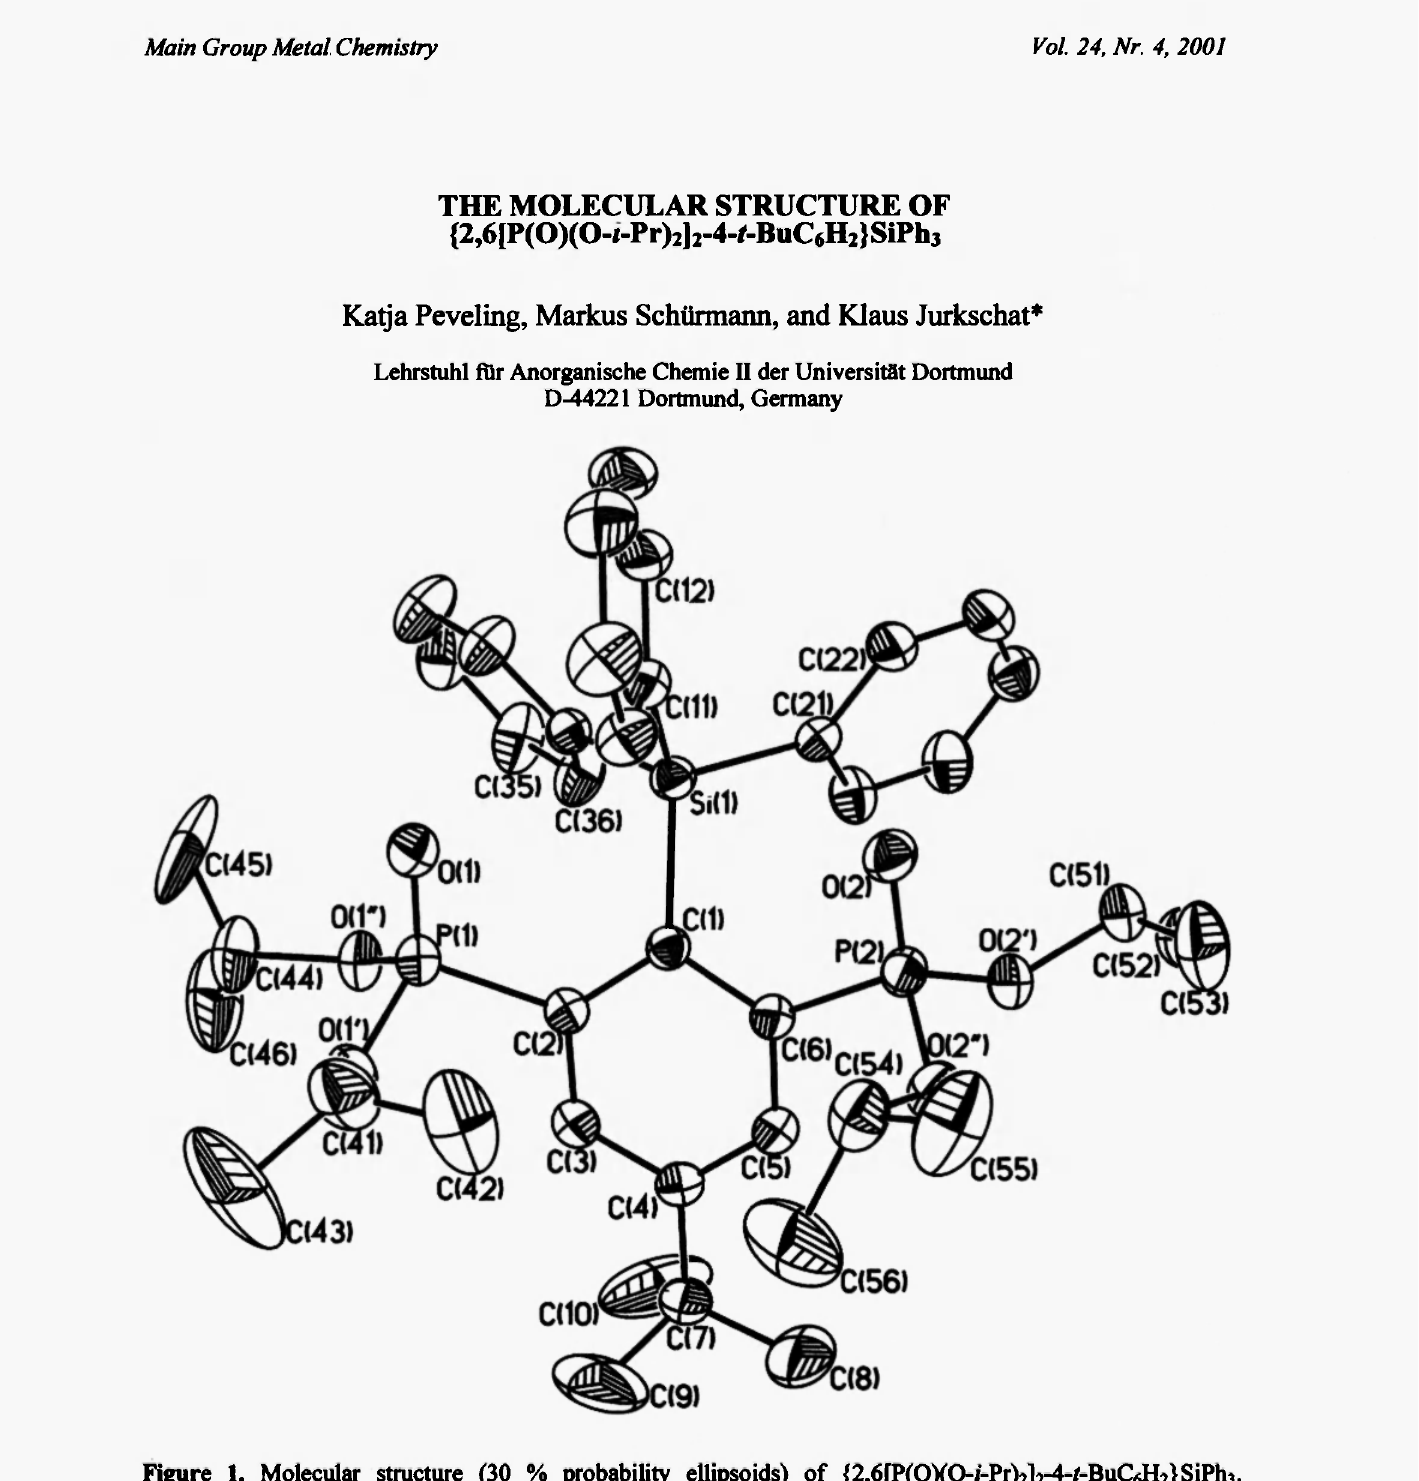
Figure 1. Molecular structure (30 % probability ellipsoids) of {2,6[P(OXO-/-Pr) Selected bond distances and angles: Si(l)-C(ll) 1.872(2), Si(l>C(31) 1.891(3), Si(l>C(21) 1.896(3), Si(l> C(l) 1.920(2), Si(l>0(l) 3.091(2), Si(l)-0(2) 3.113(2), P(1>0(1) 1.454(2), P(2>0(2) 1.458(2), C(ll)- Si(l>C(31) 109.4(1), C(1 l>Si(l)-C(21) 110.2(1), C(31)-Si(l)-C(21) 101.9(1), C(ll)-Si(l)-C(l) 118.6(1), C(31)-Si(l)-C(l) 108.7(1), C(21)-Si(l)-C(l) 106.6(1), C(ll)-Si(l)-0(1) 76.17(9), C(31)-Si(l)-0(1) 71.64(8), C(21>Si(l)-0(l) 172.46(9), 171.68(9), C(21)-Si(l)-0(2) 69.88(8), C(l>Si(l>0(2) 73.16(8), 0(l>Si(l)-0(2) 116.39(5), 0(1>P(1>C(2) 113.7(1), 0(2>P(2)-C(6) 114.4(1), P(l>0(l)-Si(l) 94.44(9), P(2>0(2)-Si(l) 93.91(8), C(l)-C(2)-P(l) 120.8(2), C(1)-C(6>P(2)